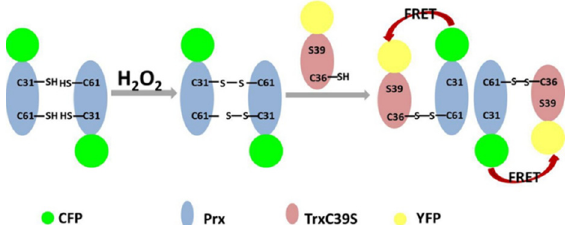
Figure 1. Schematic illustration of the working principle of proposed H 2 O 2 probe CFP-Prx / mTrx-YFP. CFP—cyan fluorescent protein, Prx—peroxiredoxin, mTrx—mutant thioredoxin, YFP—yellow fluorescent protein.